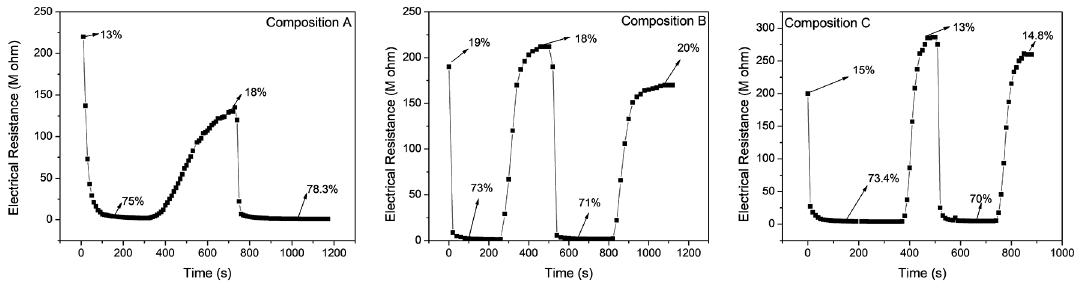
Figure 12. Response time at room temperature of compositions A, B and C sintered at